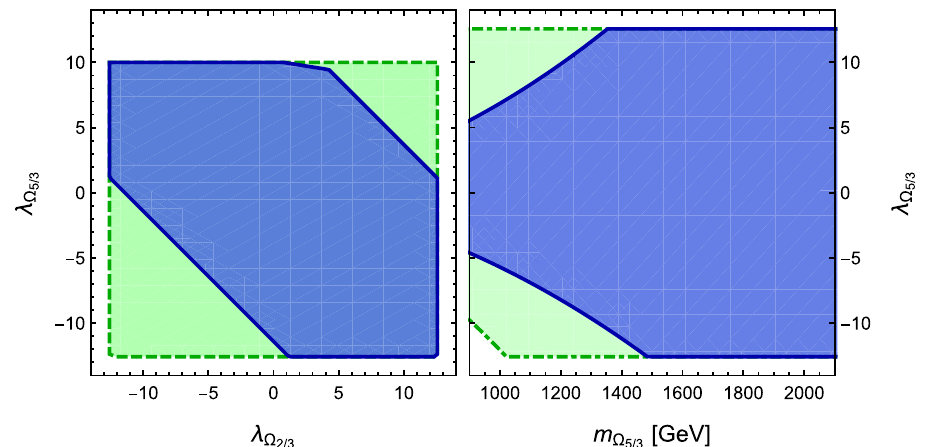
Fig. 5 Allowed regions with 95 % C.L. of the parameter space of our LQmodelfromtheexperimentalboundsontheHiggsbosonmultipliers κ γ and κ = m Ω . The left plot shows the allowed region in g for m Ω 2 / 3 5 / 3 the λ Ω vs λ Ω plane for three values of m Ω : 1000 GeV (solid-line 2 / 3 5 / 3 5 / 3 boundary), and 1500 GeV (dashed-line boundary). The right plot shows